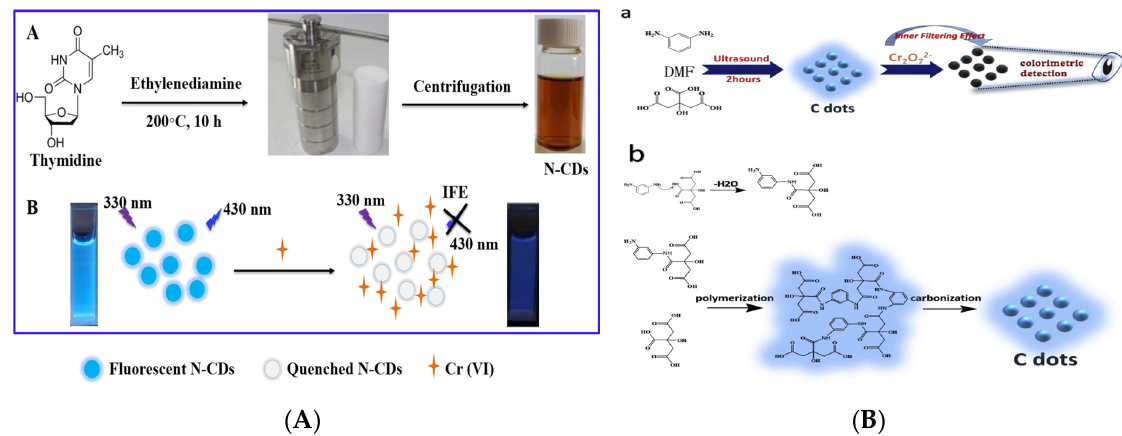
Figure 8. ( A ) Schematic of the detection of Cr 6+ by N-CQDs fluorescent sensor. Reproduced with permission from [129]. Copyright Spectrochimica Acta Part A-molecular and Biomolecular Spectroscopy, 2019; ( B ) Schematic of the CQDs for the detection of Cr 2 O 72 − (a: the detection mechanism of Cr 2 O 72 − ; b: the synthesis route of CQDs). Reproduced with permission from [131]. Copyright Dyes and Pigments, 2019.